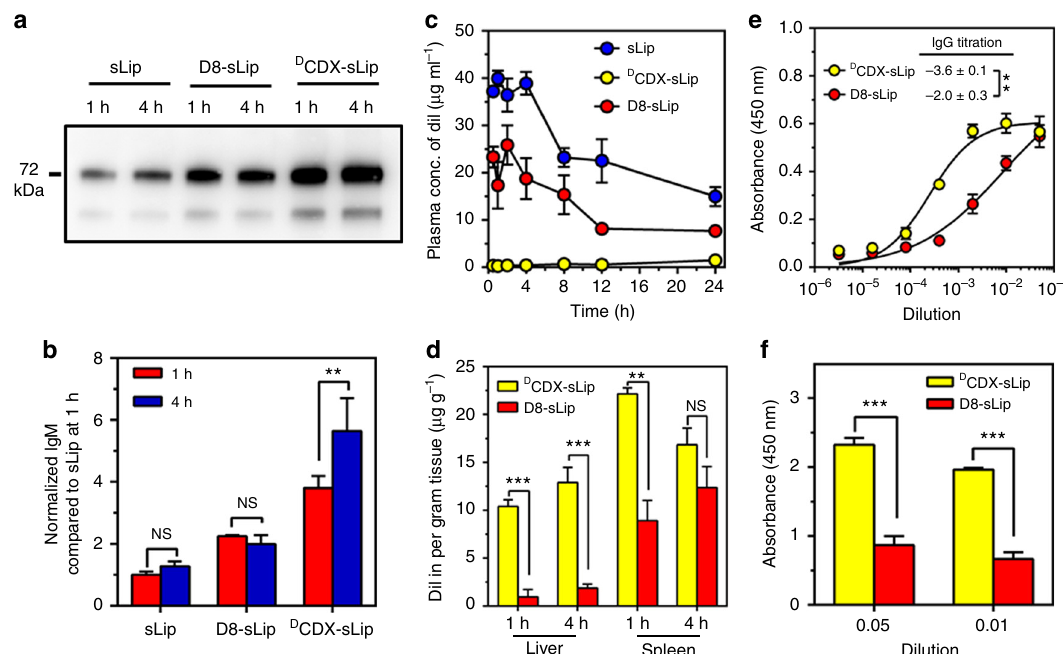
Fig. 8 Immunocompatibility of D8-sLip. a , b Western blot assay ( a ) and quanti fi cation ( b ) of natural IgM on liposomal surface in vivo 1 and 4 h after injection. c Pharmacokinetic pro fi les of sLip, D8-sLip, and D CDX-sLip. d Biodistribution in liver and spleen of BALB/c mice of D8-sLip and D CDX-sLip. e IgG titrations. Absorbance in the ELISA plate versus serum dilution and antibody titer reported as log (EC50). D8-PEG3400-DSPE and D CDX-PEG3400-DSPE was used as antigens for D8-sLip and D CDX-sLip, respectively. f Absorbance in the ELISA plate for anti-PEG IgM evaluation. mPEG2000-DSPE was used as antigen for both formulations. n = 3, data are means ± s.d. Statistical signi fi cances were calculated by Student ’ s t -test. NS indicates not signi fi cant, * p < 0.05, ** p < 0.01, *** p <